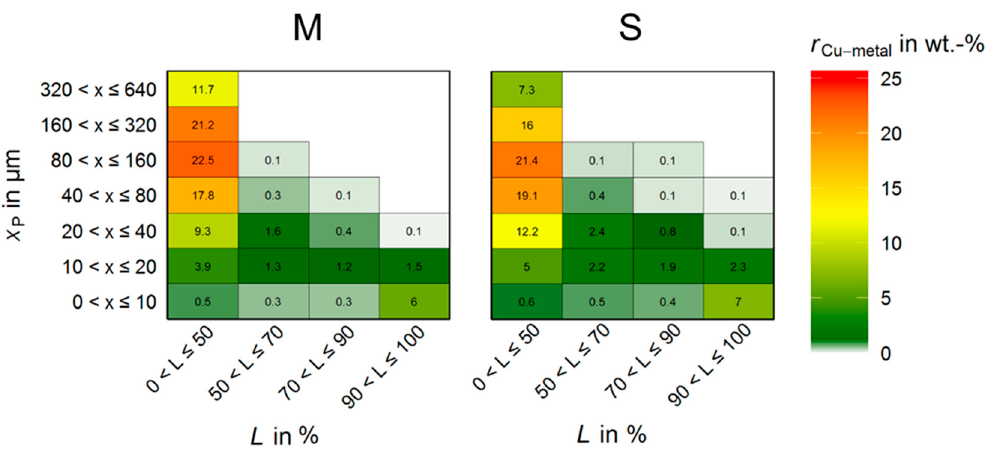
Figure 16. Theoretical recovery ( r Cu-metal ) of the Cu-metal phase into size ( x P ) and liberation ( L ) classes for the two main products M and S.